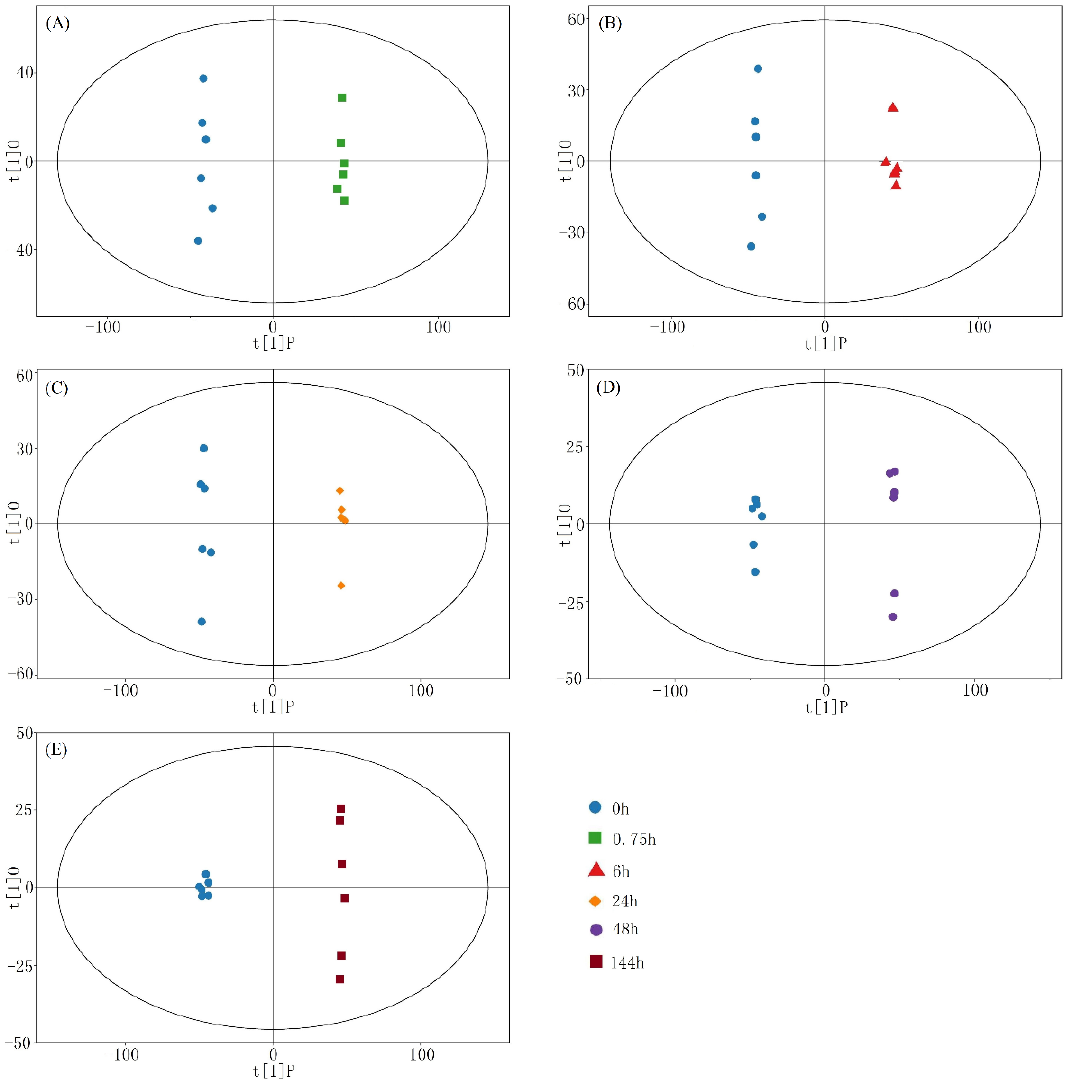
Figure 2. Orthogonal partial least squares-discriminate analysis (OPLS-DA) score plots of metabolic profiles during different seed germination times. ( A – E ) OPLS-DA score plots of seed germination at 0 and 0.75 h ( A ), 0 and 6 h ( B ), 0 and 24 h ( C ), 0 and 48 h ( D ), and 0 and 144 h ( E ).